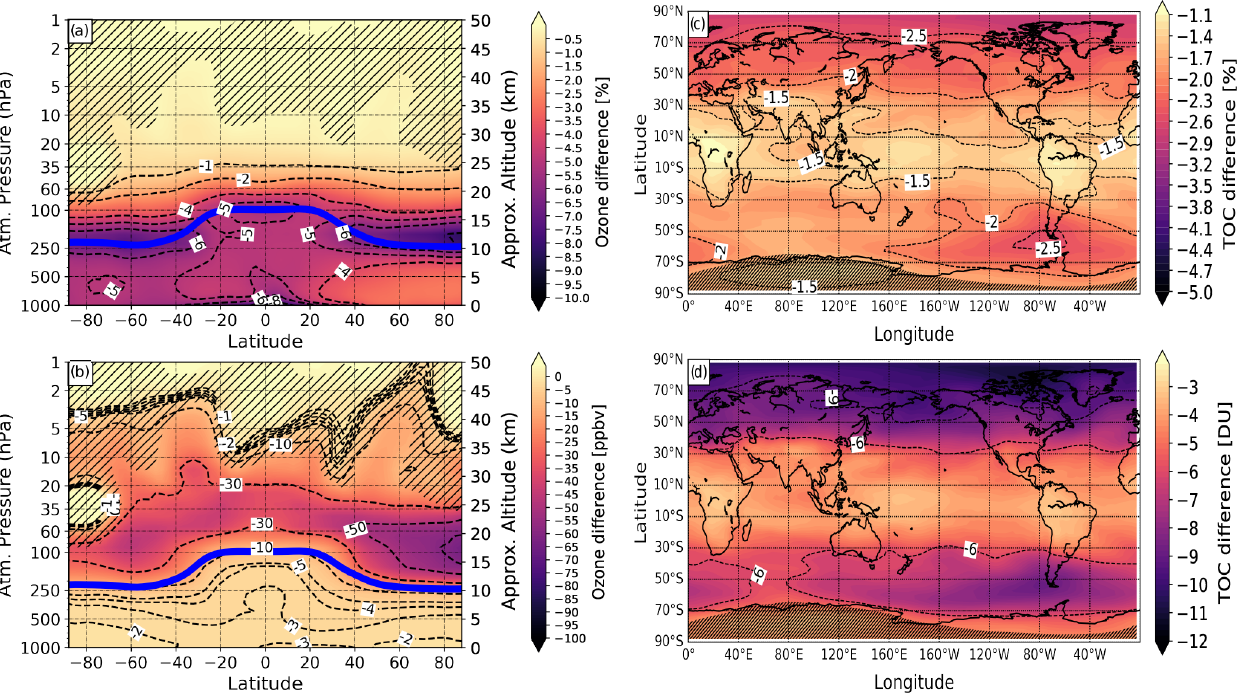
Figure 8. Modeled effect of 2-fold iodine chemistry on annual-mean ozone climatology averaged for the 2000–2009 period and 10 ensemble members. (a, c) Ozone changes of the case with 2-fold iodine chemistry (2 × iodine) relative to present-day iodine emissions (1 × iodine) in percent. (b, d) Corresponding absolute ozone changes in parts per billion by volume (ppbv) and Dobson units (DU), respectively. Blue solid line in (a) and (b) : annual mean tropopause height. Hatching marks regions with iodine effect on ozone having a confidence level less than